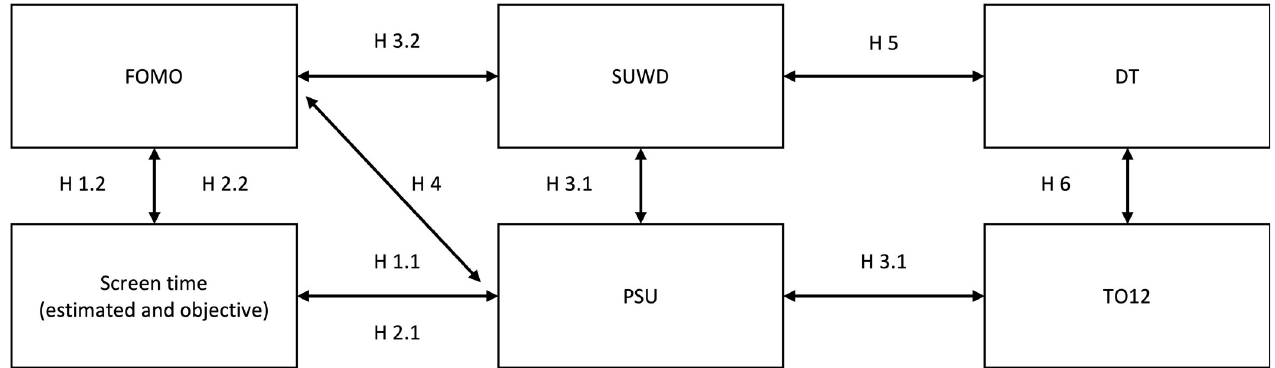
Fig 1. Overview of hypotheses of the study. Note . FOMO = Fear of missing out; SUWD = Smartphone use while driving; DT = Dark Triad traits; Screen time (estimated and objective) = Estimated screen time and objective screen time; PSU = Problematic smartphone use; TO12 = Penalized traffic offenses in the last 12